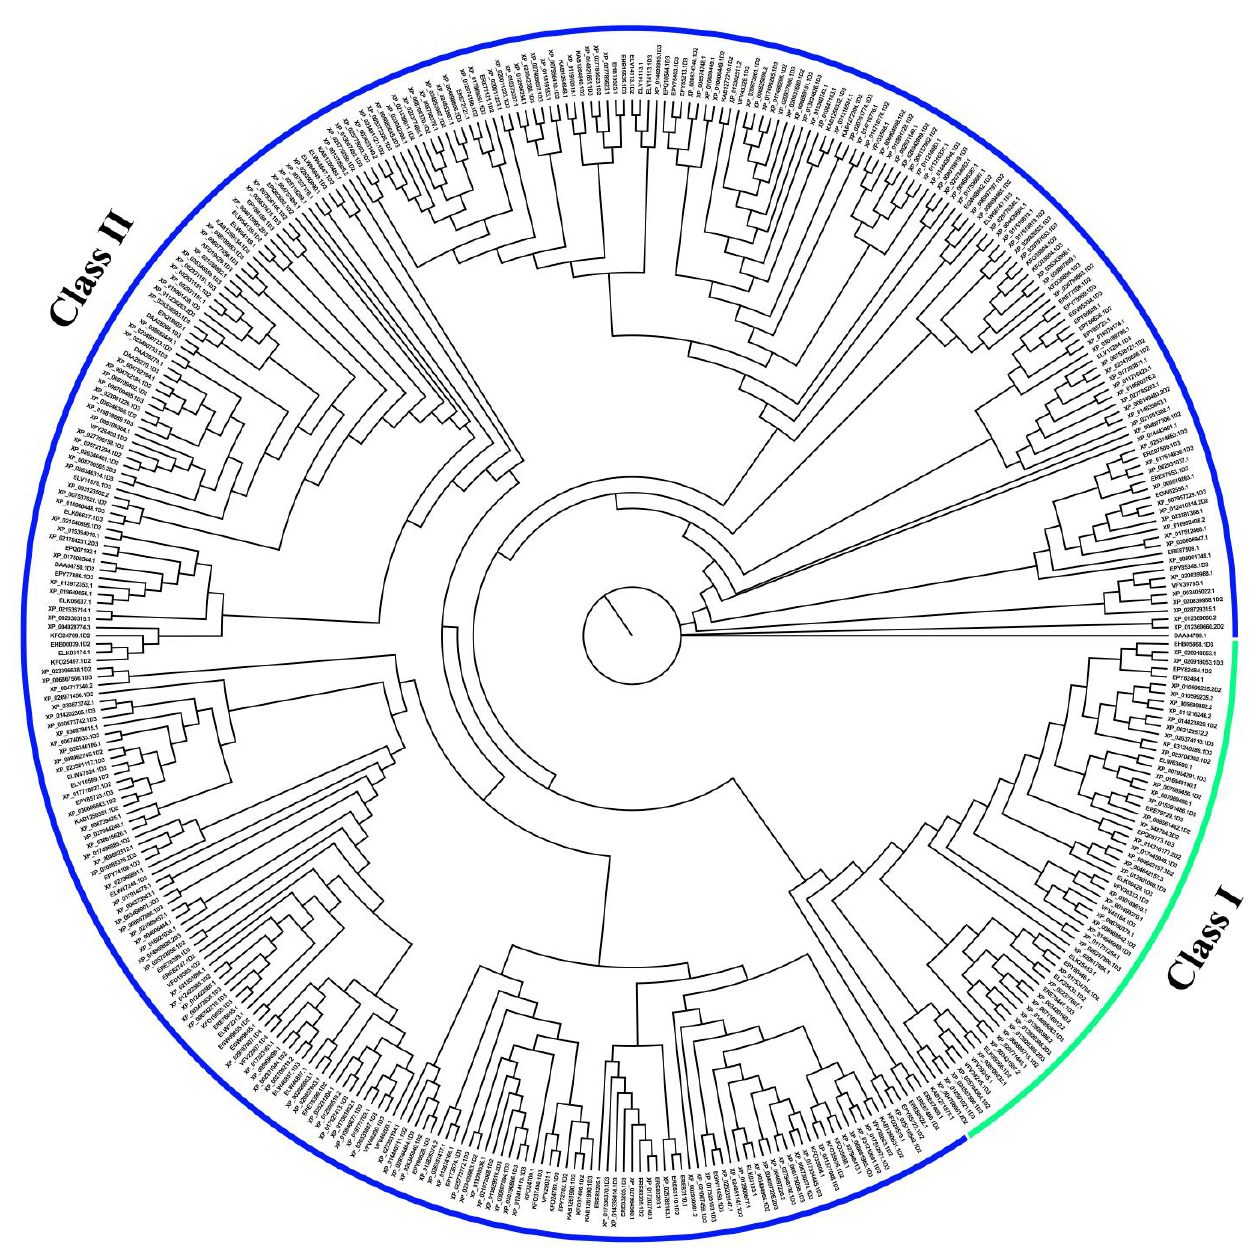
Figure 4. The phylogenetic tree of functional OR genes in the giant panda.